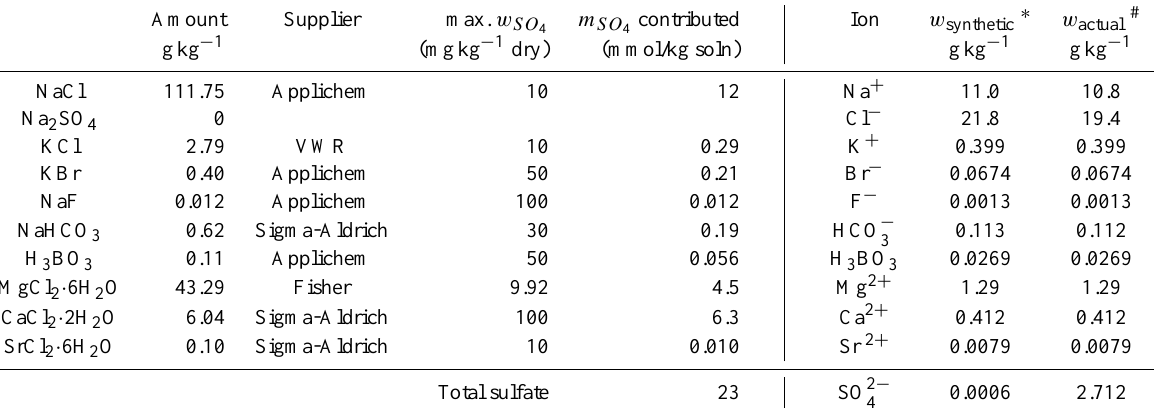
Table 2. Compounds used to prepare a four-times concentrated sulfate-free synthetic sea salt solution. ∗ Prepared solution was four times more concentrated than actual sea salt, so here it is divided by four to facilitate comparison with actual concentrations. # From Millero (1974). m SO Amount Supplier max. w SO 4 4